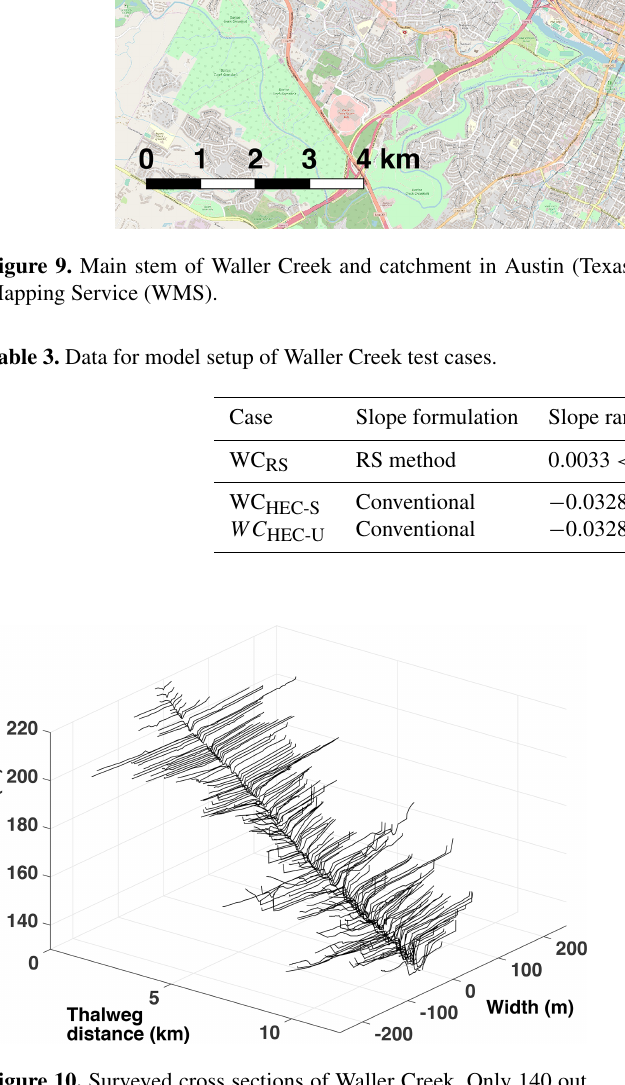
Figure 10. Surveyed cross sections of Waller Creek. Only 140 out of 327 cross sections are shown for clarity. Elevations are relative to mean sea level. Data courtesy of the city of